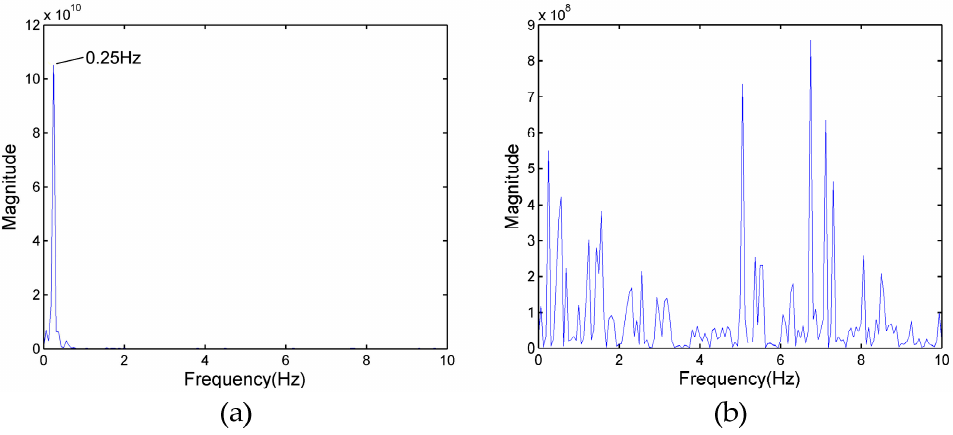
Figure 6. ( a ) The frequency spectrum of Figure 5a processed by auto-correlation; and ( b ) the frequency spectrum of Figure 5b processed by auto-correlation.